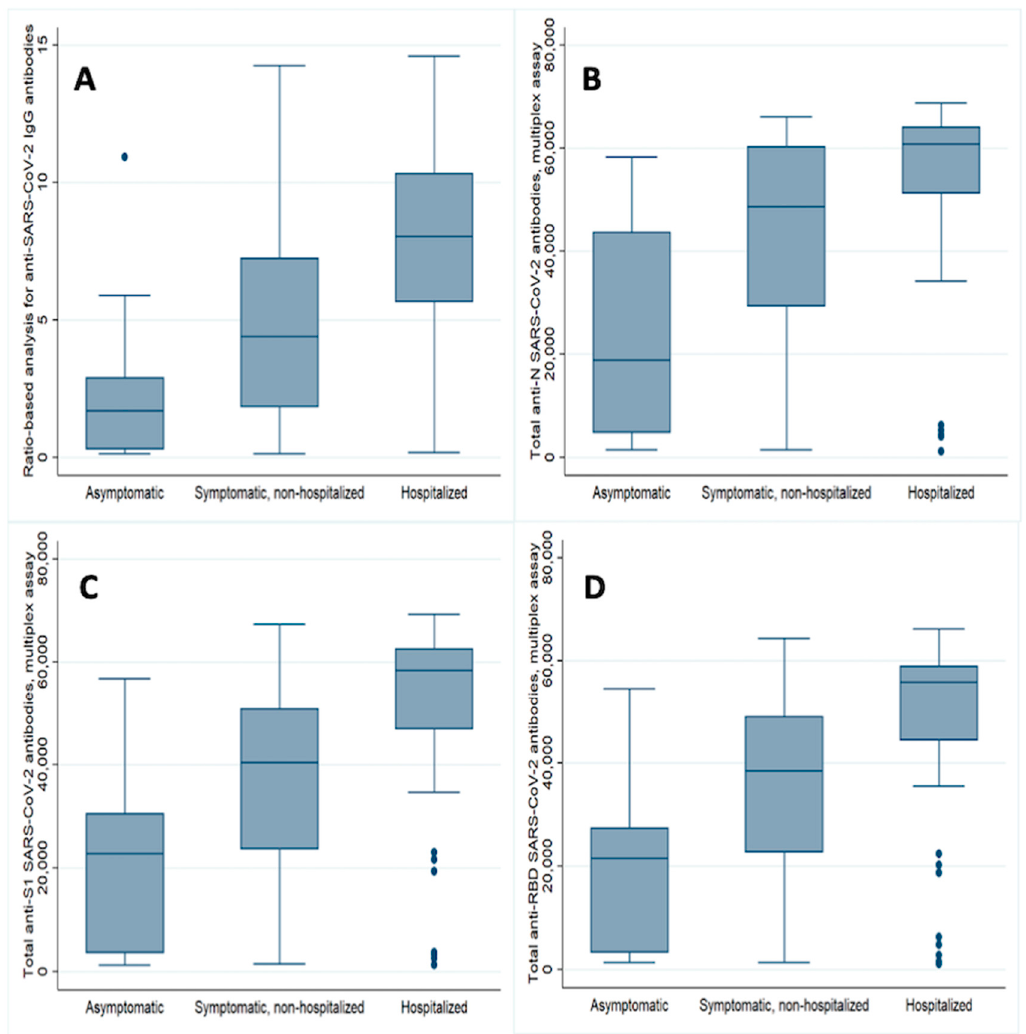
Figure 1. Convalescent plasma donors anti-SARS-CoV-2 antibodies against all studied epitopes on the day of screening, according to disease severity ( A – D ). The median ratio (IQR) for anti-S1-IgG antibodies using the Euroimmun ELISA method were as follows: 1.69 (2.59) vs. 4.40 (5.42) vs. 8.04 (4.69) for asymptomatic, non-hospitalized symptomatic and hospitalized symptomatic, respectively ( p = 0.0001, Kruskal–Wallis test); ( A ) the respective values of the median fluorescent intensity (IQR) for the total (IgM + IgA + IgG) antibodies, using the multiplex assay, against basic nucleocapsid (N) protein were: 18,875 (38,803) vs. 48,703 (30,981) vs. 60,913 (12,810) ( p = 0.0001; ( B ) while against S1 were 22,806 (26,735) vs. 40,436 (27,514) vs. 58,377 (15,733) ( p = 0.002)); ( C ) and against receptor-binding domain (RBD) were 21,515 (24,077) vs. 38,556 (26,393) vs. 55,869 (14,522) ( p = 0.002; ( D )).